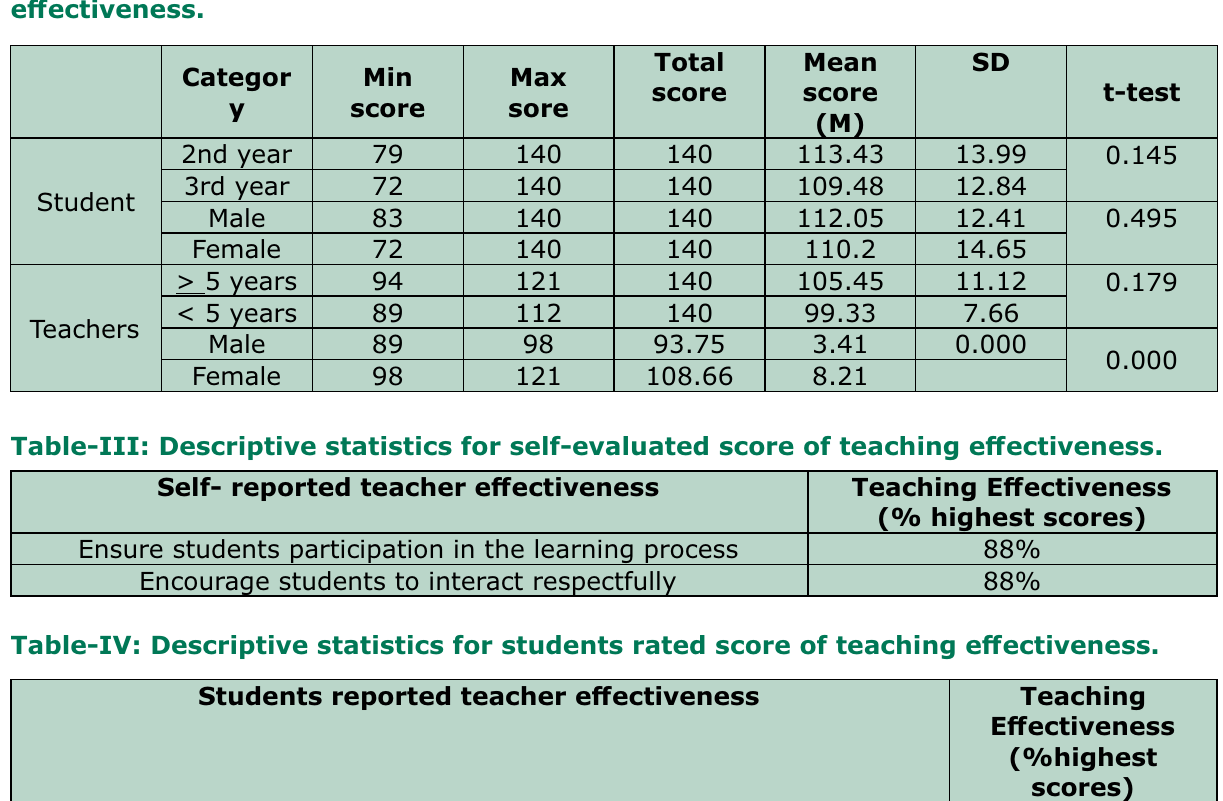
Table-II: Inferential Statistics for self-evaluated and students reported teaching effectiveness.